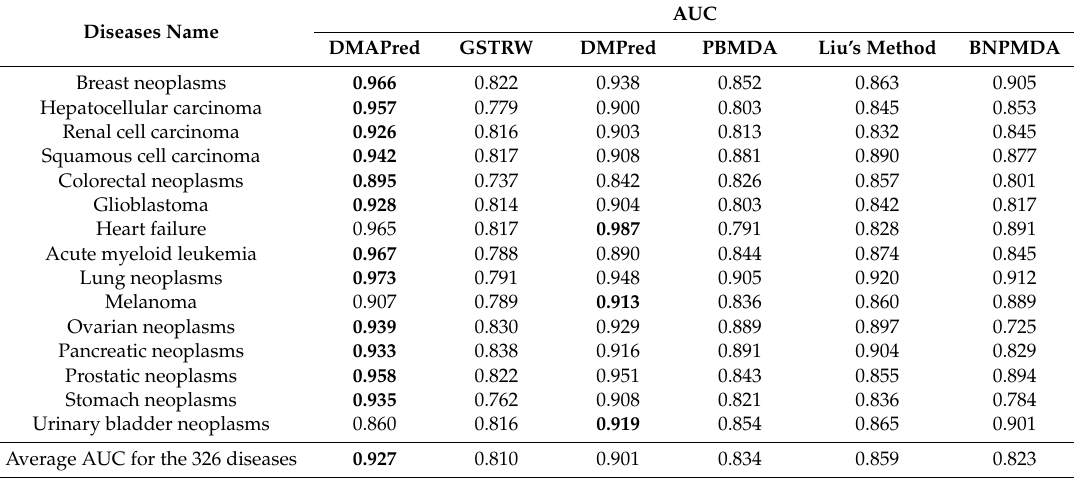
Table 1. AUC values of five methods for all the diseases and 15 common diseases. Diseases Name